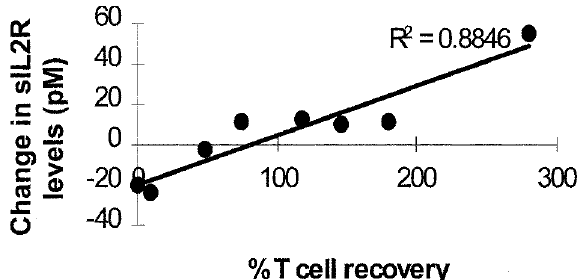
FIG. 2. Correlation between change in sIL2R levels from POD5 to POD7 and T-cell recovery on POD10 in rejecting